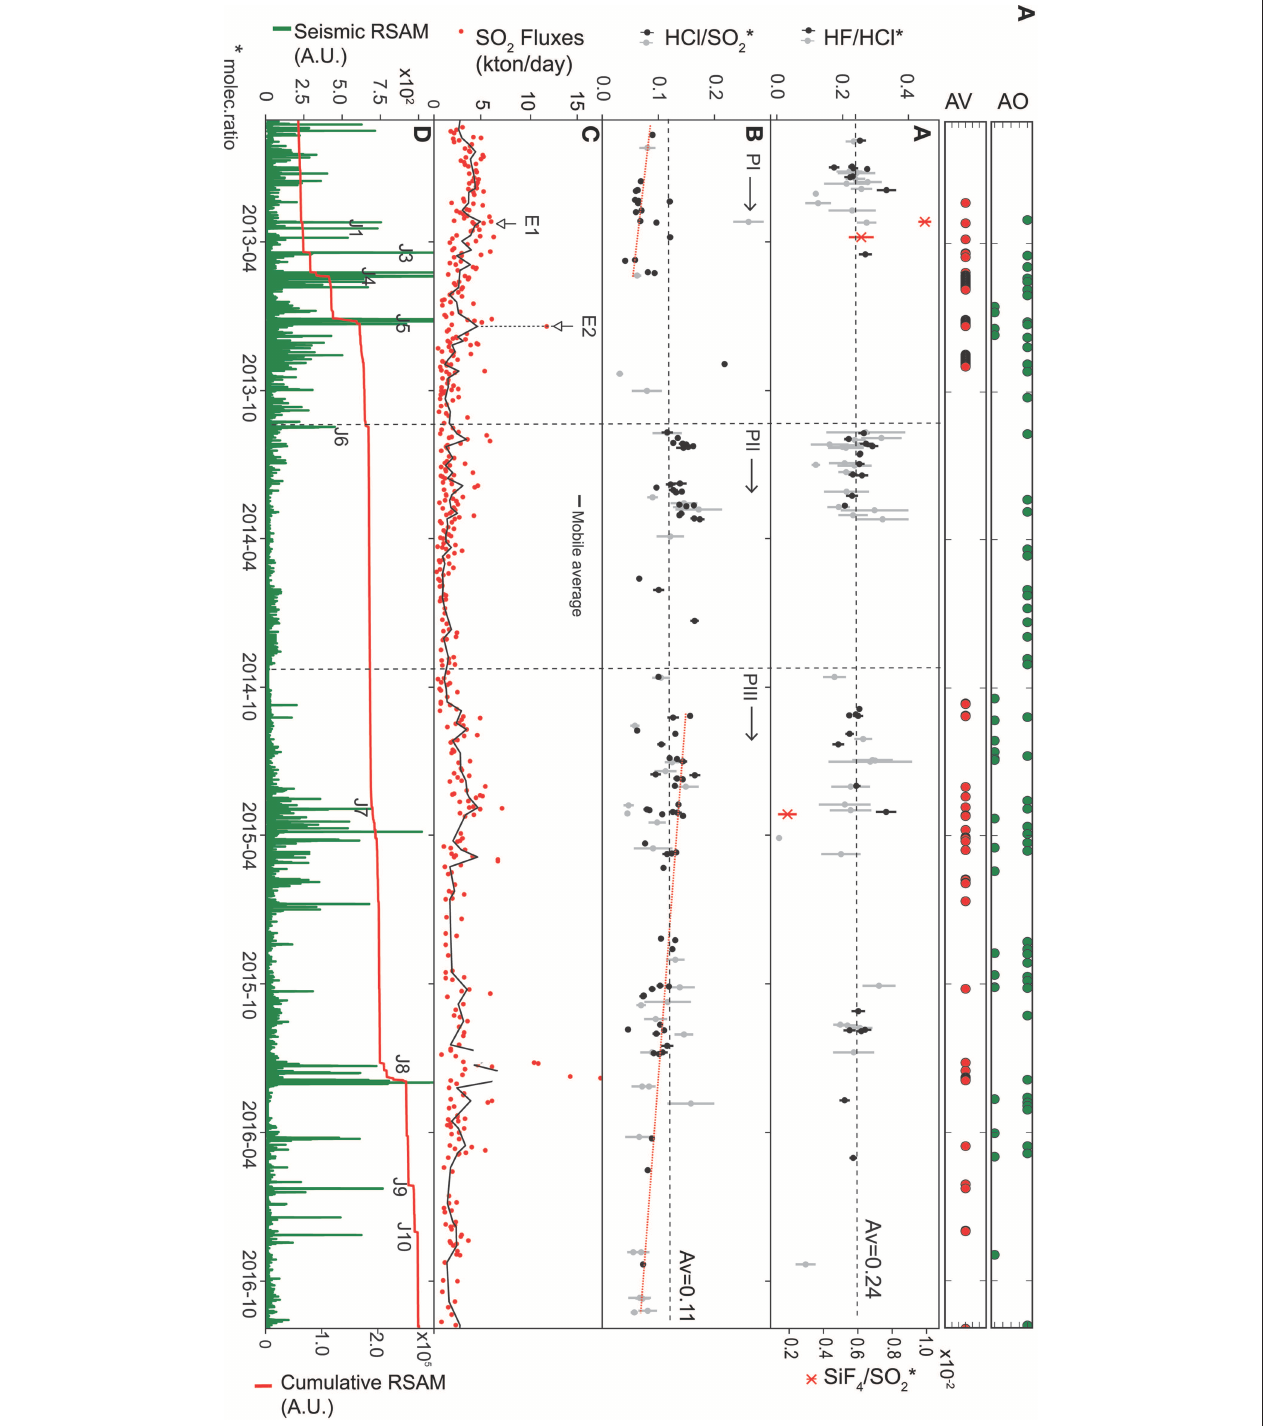
FIGURE 2 | Time series of the Popocatépetl plume composition between 2012 and 2017 for (A) SiF 4 /SO 2 (red) and HF/HCl molecular ratios (black for datapoints with error 6 10% and gray for those with error > 10%) (B) HCl/SO 2 molecular ratios (black for datapoints with error 6 10% and gray for those with error > 10%), obtained from FTIR solar absorption measurements. The vertical dashed lines represent the beginning of each of the period PI, PII and PIII defined in Table 2 . (C) SO 2 fluxes obtained from the OMI satellite measurements (red) and their moving average (black) over 5 points (D) seismic RSAM (green) and its cumulative curve (red) obtained from the Canario seismic station. J1–J10 indicate the main cumulative RSAM shifts. Top of the figure: AO, Aerial observations including overflights of the Popocatépetl crater and satellite observations from USGS. The presence of a lava dome is indicated by the position of the point (Top = Yes, Bottom = No). AV, Ash Venting